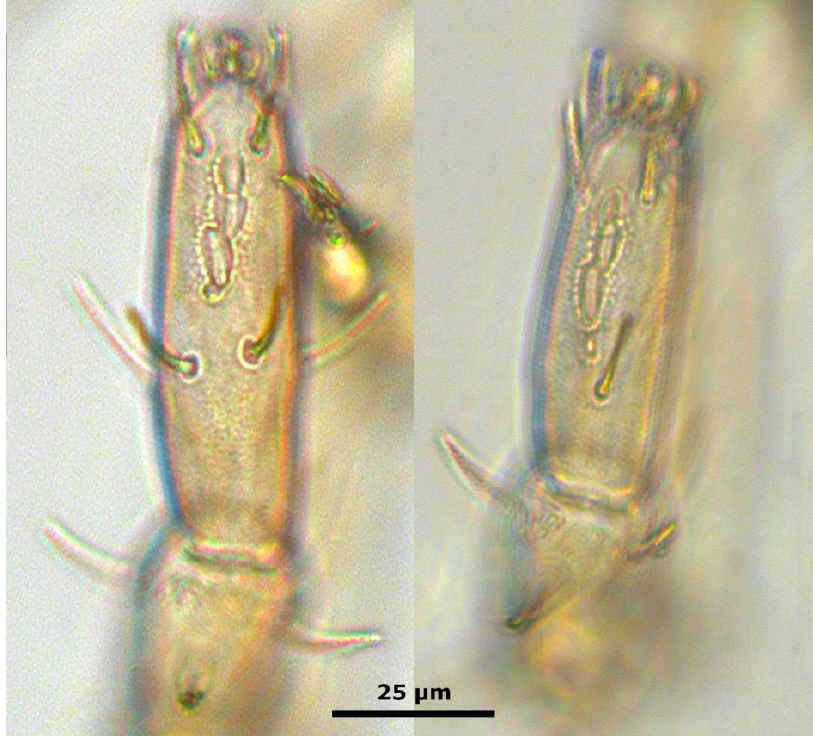
Figure 2. S. ineffabilis sp. nov. Asymmetry of the rhagidial organs on tarsi I (left) and II (right) subtended by small nude round setae in the specimens from Inexpressible Island. Apical rhagidial organs on tibiae I and II also visible.